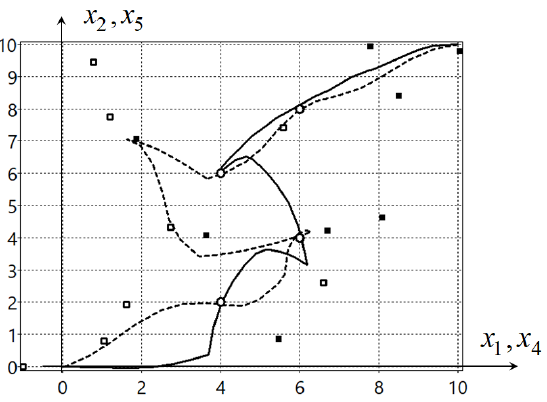
Figure 1. Optimal trajectories of robots for synthesized control In the Figure 1 the solid black line is a trajectory of the first robot, the dash line is a trajectory of the second robot, the small circles are the bottlenecks, the small black squares are the optimal control points (63) for the first robot, and the small white squares are the optimal control points (63) for the second robot. The optimal value of the functional (56) is